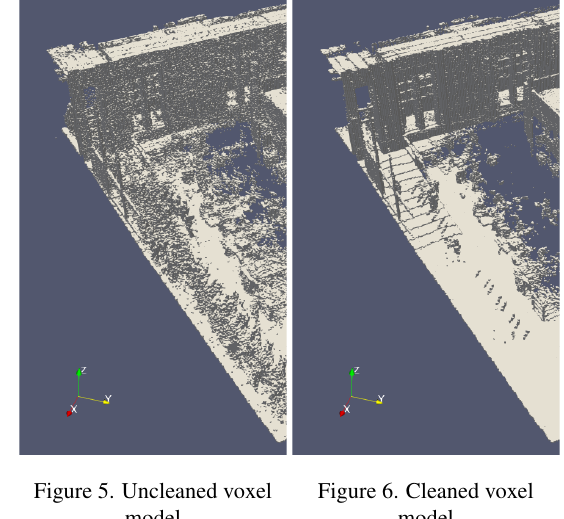
Figure 5. Uncleaned voxel Figure 6. Cleaned voxel model model